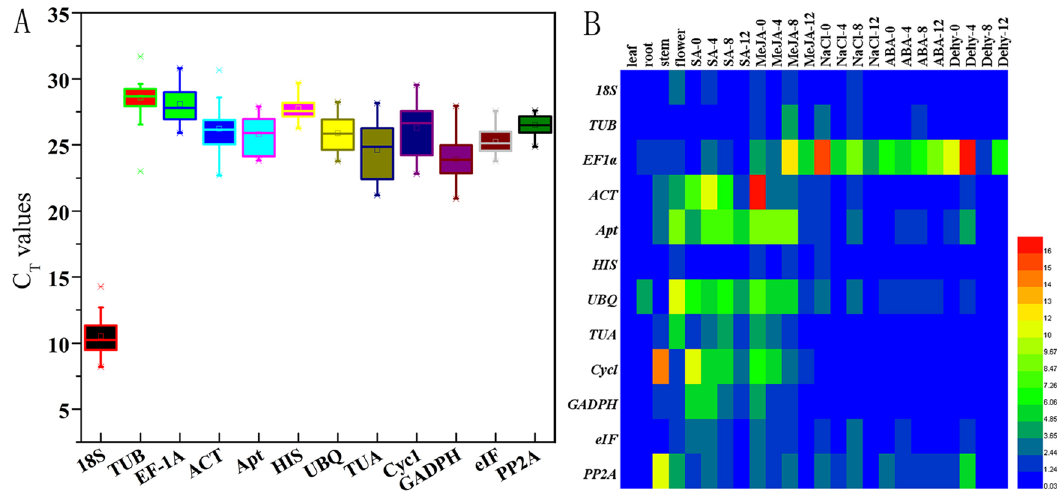
Figure 2. Expression stability of the 12 tested candidate reference genes in all 24 samples. ( A ) Box-plot graphs of Ct-values for each candidate reference gene. The plots highlight the mean (hollow square), median (center line), maximum, and minimum (whiskers, the vertical lines), and 25th and 75th percentiles (boxes) of the data. ( B ) Heat map showing FC fold change values of gene relative expression levels in all 24 samples. The color scale represents the gene relative expression level. Low to high expression is represented over a spectrum from blue to red, respectively.